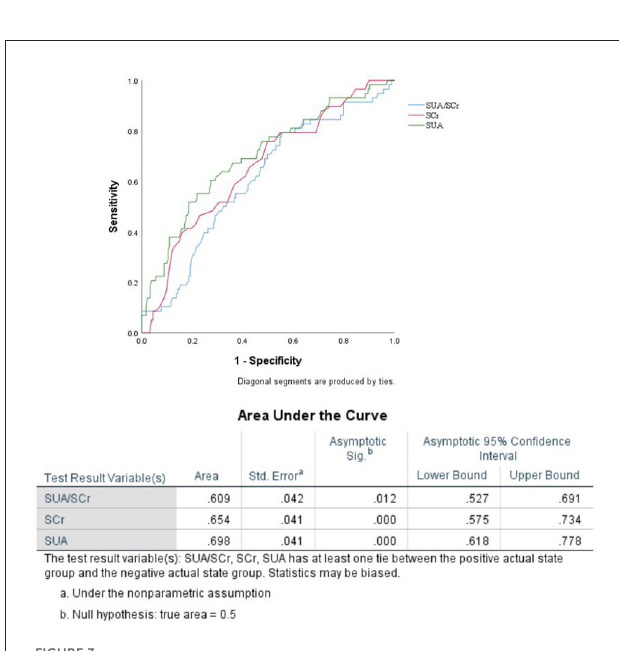
FIGURE3 ROC analysis of SUA/SCr in predicting END in BAD patients.